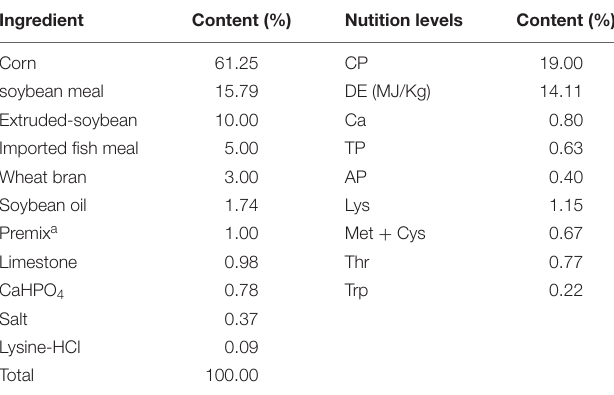
TABLE 1 | Ingredient and chemical composition of the basal diet (as-fed